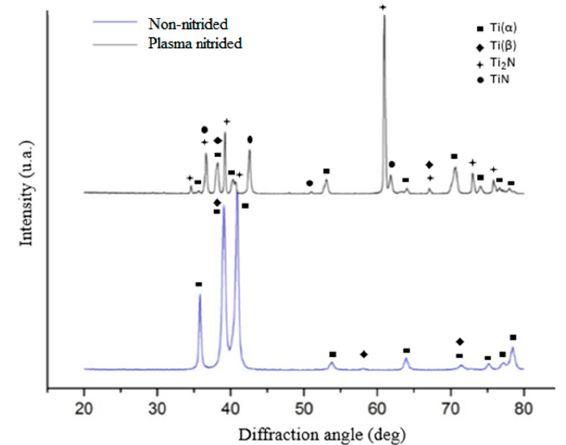
Figure 3. X-ray diffraction of the non-nitrided and nitrided Ti-6Al-4V alloy. Top: plasma nitrided alloy. Bottom: non-nitrided alloy. Bottom: non-nitrided